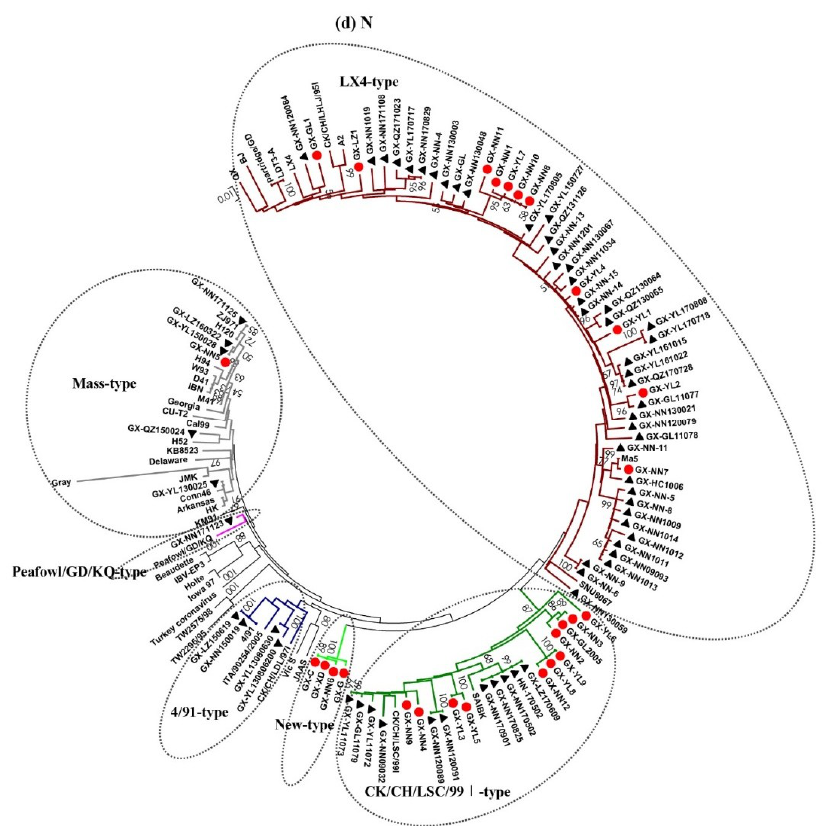
Figure 1. Phylogenetic trees of gene S1 ( a ), E ( b ), M ( c ), and N ( d ) of IBVs, where the 64 IBV strains isolated during 2009–2017 are marked with filled black triangles and 27 IBV strains isolated during 1985–2008 are marked with filled red circles. Each type of IBV was grouped in one circle and the representative strains were boxed. Phylogenetic trees were constructed with the neighbor-joining method using MEGA version 6.06. The bootstrap values were determined from 1000 replicates of the original data. The branch number represents the percentage of times that the branch appeared in the tree. Bootstrap values greater than 50% are shown. The p -distance is indicated by the bar at the bottom of the figure.